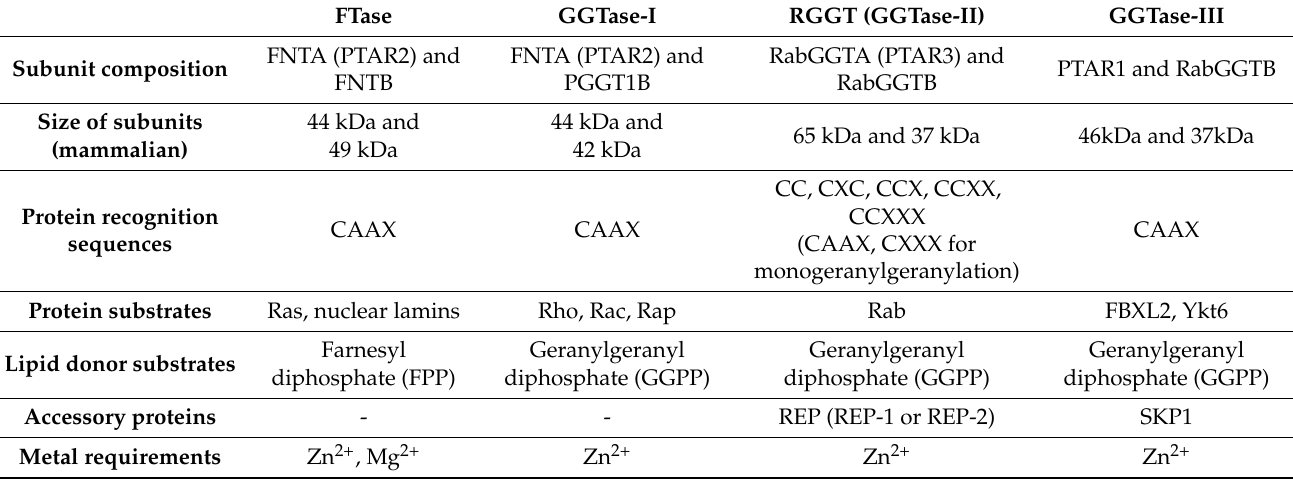
Table 1. Comparison of the structure and biochemical properties of protein